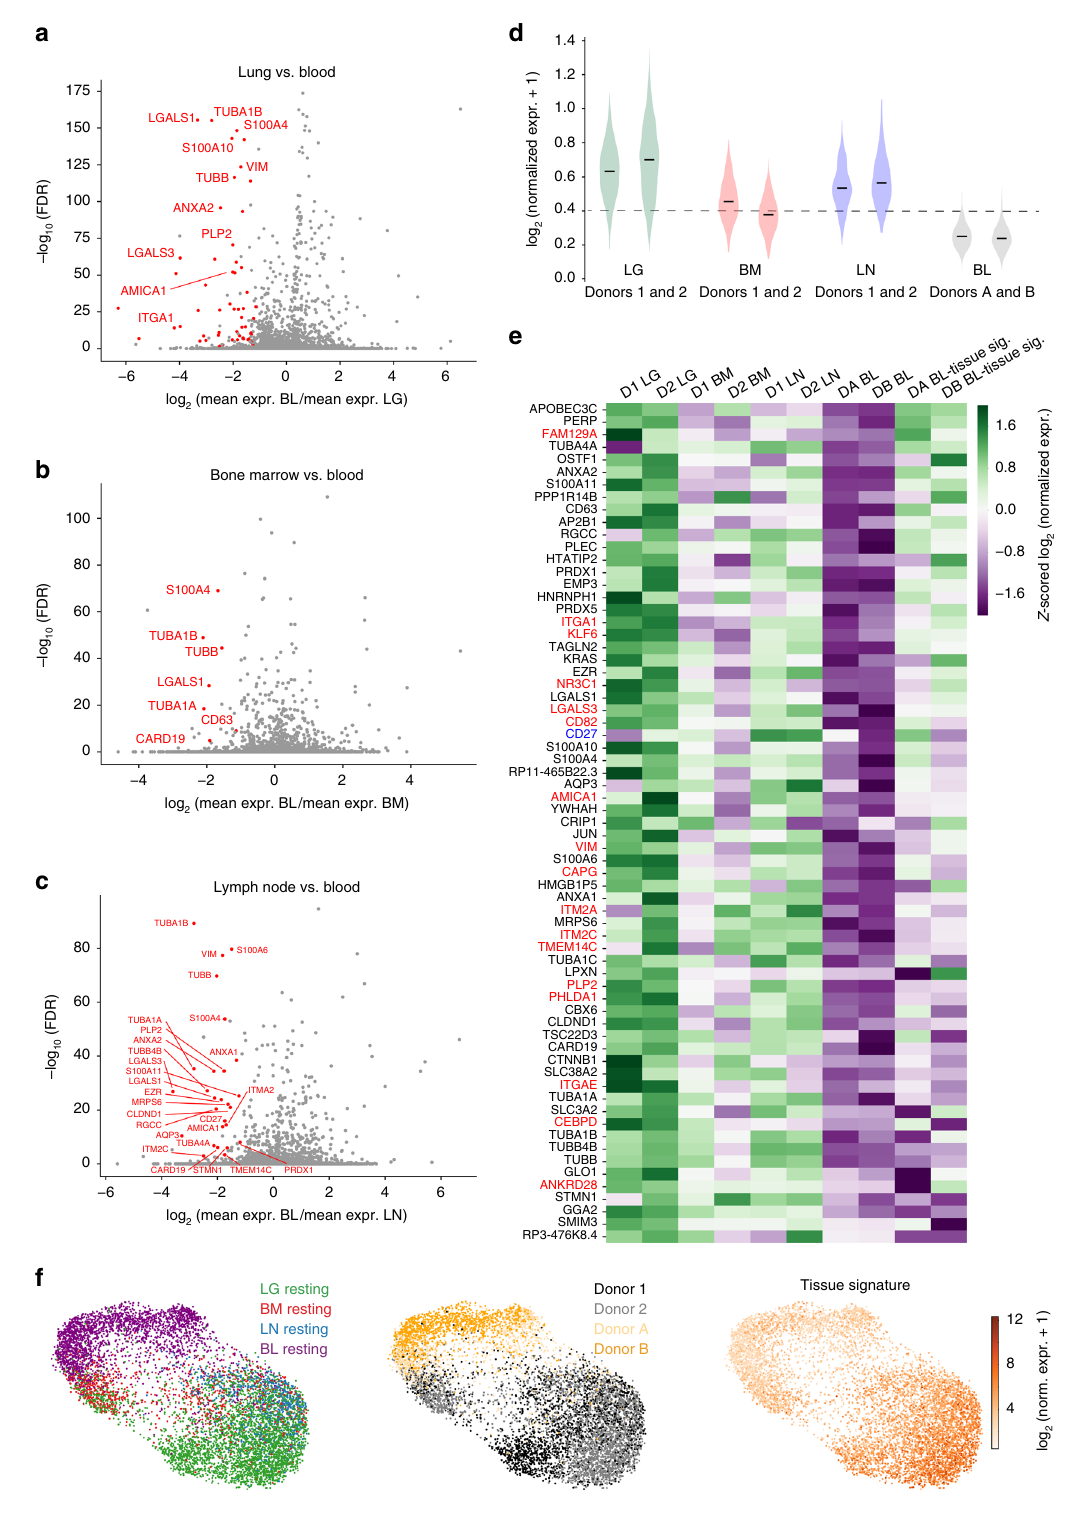
from BM (Fig. 3d). Notably, a minute fraction of blood TEM cells (<0.5%) express this tissue signature at levels comparable to that in LN (within one standard deviation of the mean for all tissues). Shown in a heat map are the relative expression levels for genes within the tissue signature, including genes enriched in human TRM cells 13,36 , and genes associated with cytoskeletal, cell-matrix interactions, cell division, apoptotis, and signaling (Fig.